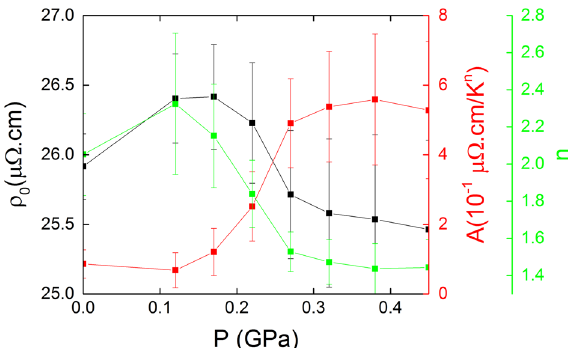
Fig. 8 The pressure dependence of residual resistivity ( ρ 0 ), A coef fi cient and power n as evaluated from the temperature dependencies of the electrical resistivity in the case of the UCo 0.990 Ru 0.010 Al sample. The error bars are determined by uncertainty of the model parameters, see Methods section for details Fig. 9 Schematic view of the proposed phase diagram in the